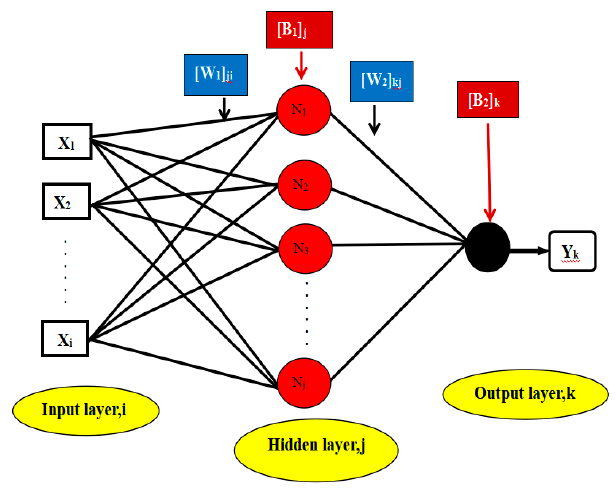
Figure 5. Schematic diagram of an artificial neural network.